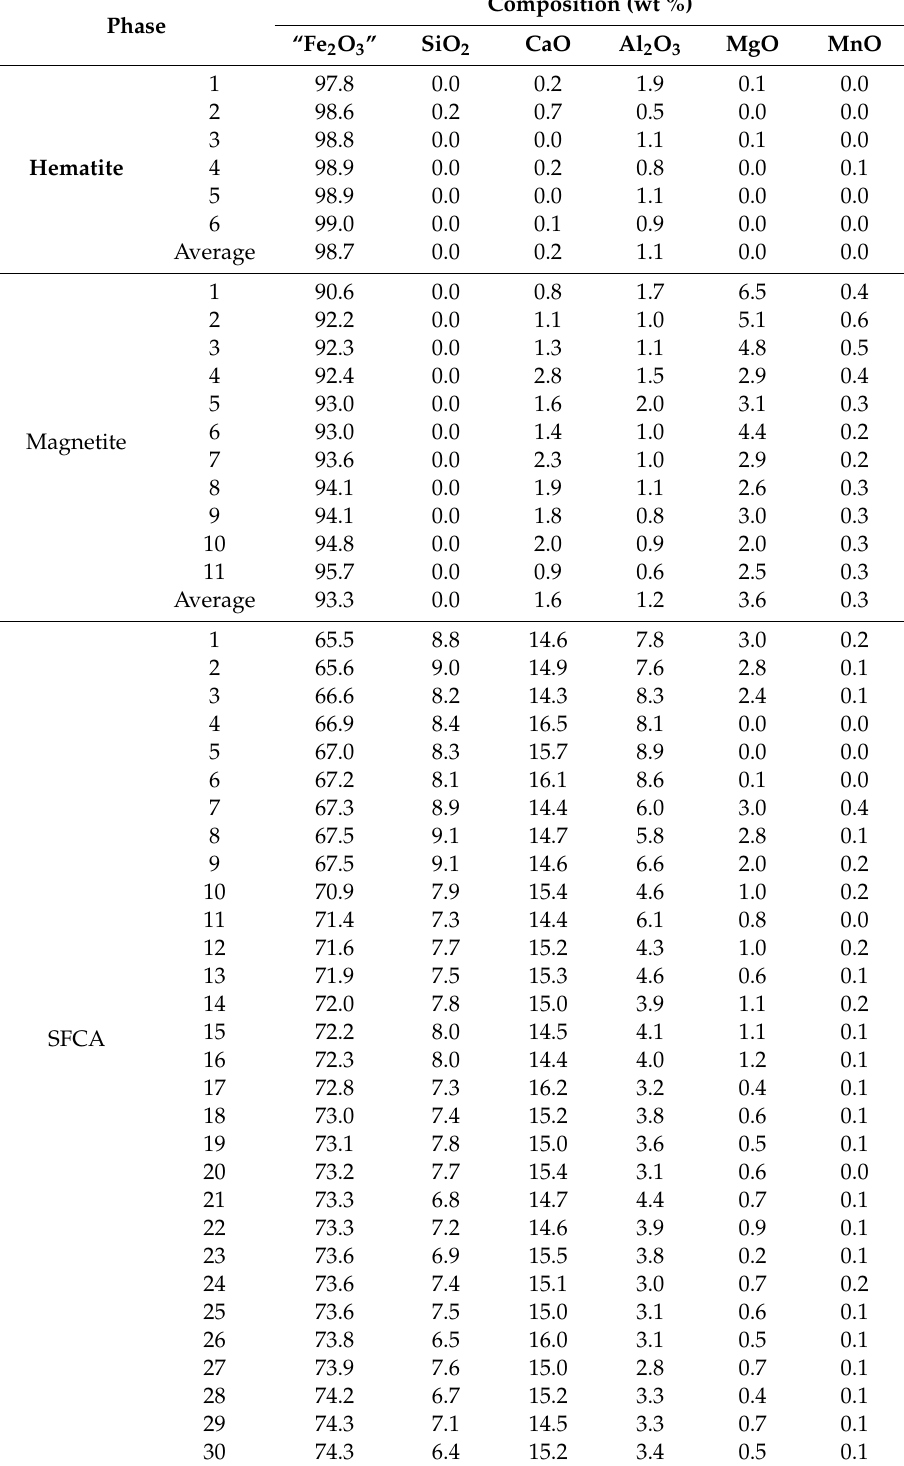
Table 2. Measured phase compositions (electron probe X-ray microanalysis;